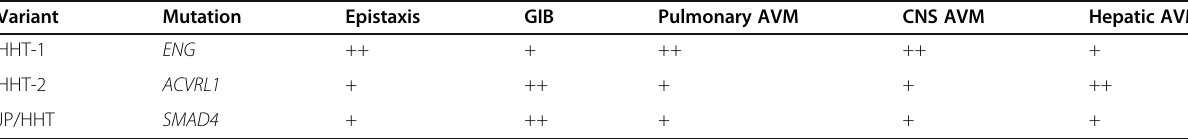
Table 2 Genotype to